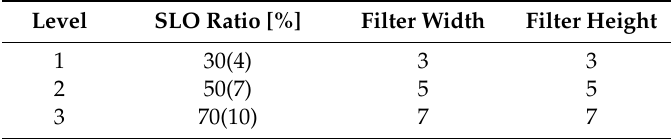
Table 2. 3-level parameter table including SLO ratio and size of the convolution filter.